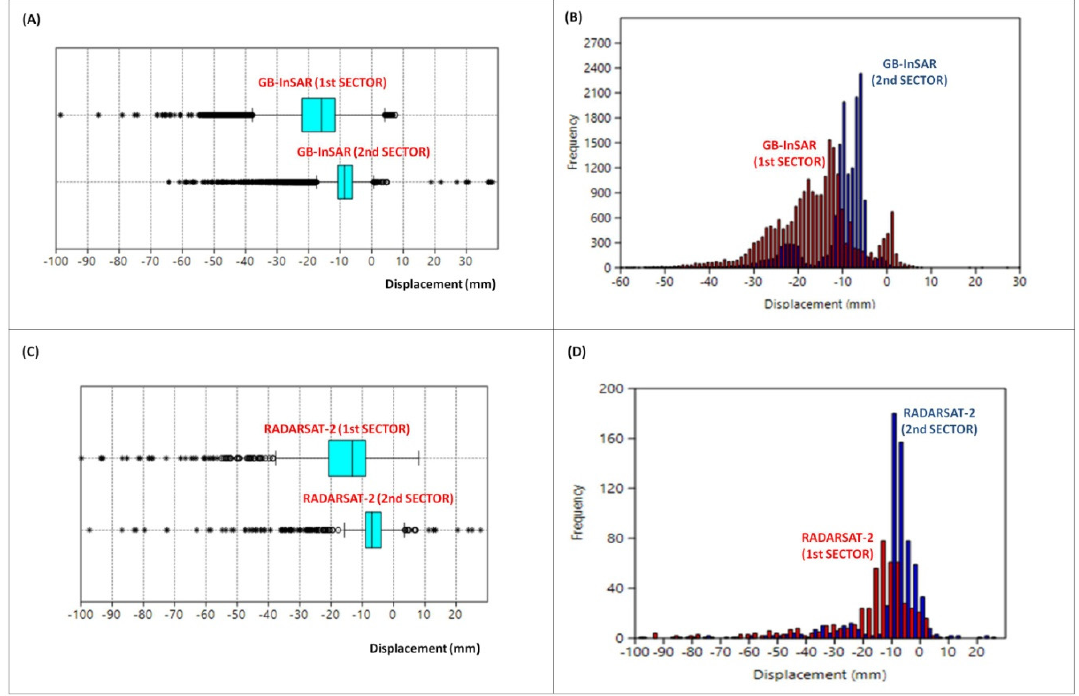
Figure 13. Box plots ( A ) and histograms ( B ) of GB-InSAR datasets, referring to the first and second sectors identified in Figure 12; box plots ( C ) and histograms ( D ) of RADARSAT-2 datasets, referring to the first and second sectors identified in Figure 12.